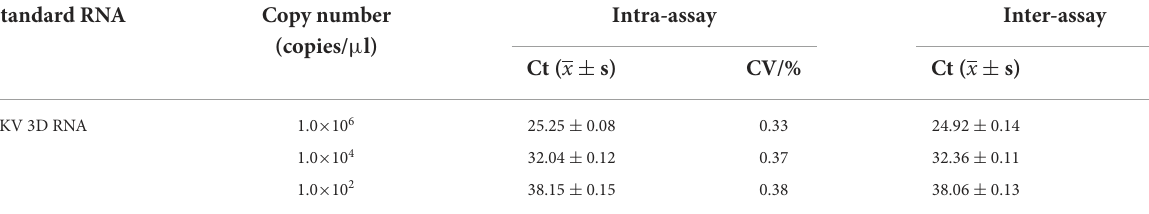
TABLE 3 Reproducibility of the real-time RT-PCR evaluated with standard RNA of BKV. Standard RNA